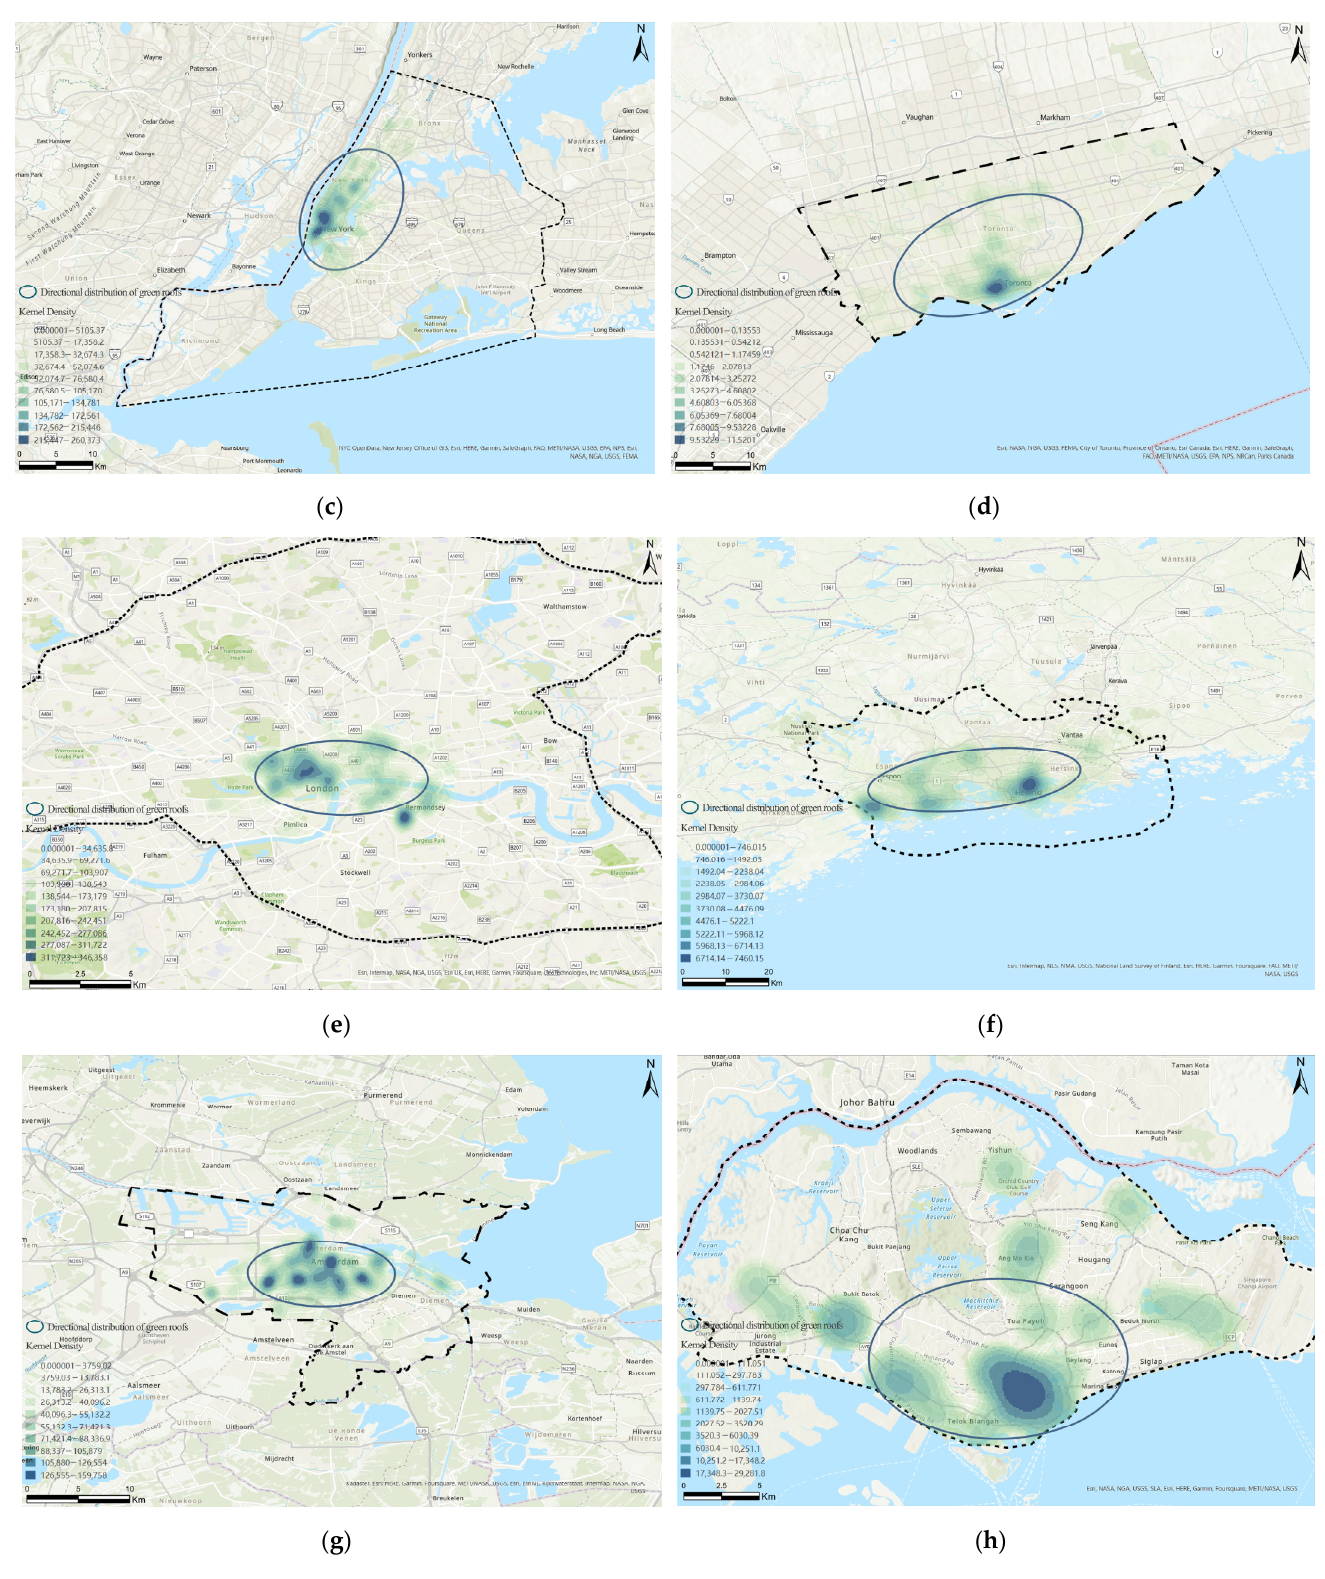
Figure 4. Spatial distribution direction and density of green roofs. ( a ) San Francisco; ( b ) Chicago; ( c ) New York; ( d ) Toronto; ( e ) London; ( f ) Helsinki; ( g ) Amsterdam; ( h ) Singapore. In this study, the mean nearest neighbor tool in the spatial statistics of Geographic The density distribution of green roofs is also shown in Figure 4. Kernel density Information System (GIS pro) was used to calculate the mean distances between each ob- estimates were performed to generate a heatmap with the number of green roofs served point and its nearest neighboring point. Then, the mean was compared with the expected value from the complete spatial randomness (CSR) pattern to obtain the stand- ard deviation (Z-score) [53]. When the z-score is negative and the value is small, the dis- tribution pattern is clustered, while the opposite suggests dispersed [54]. In addition, the nearest neighbor index (NNI) can also be used to judge whether the point pattern is clus- tered or dispersed, which can be calculated using Equation (1): = ( ) = ∑ ⁄ 0.5 ⁄ (1) where is the distance from each green roof to its nearest neighbor green roofs. ( ) is the expected value of the distance from each green roof to its nearest neighbor green roofs in the random distribution mode. N is the number of green roofs in the region, and A is the study region [55]. If NNI > 1, the distribution pattern is dispersed; NNI ≈ 1, the distribution pattern is random; and NNI < 1, the distribution pattern is clustered [56]. The parameters of the average nearest neighbor analysis are shown in Table 1. The nearest neighbor indexes (NNI) of all eight regions are less than 1 and the Z- scores are all